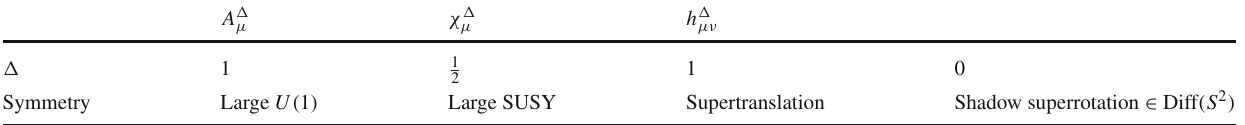
Symmetry Large U ( 1 ) Large SUSY Supertranslation Shadow superrotation ∈ Diff ( S 2 )